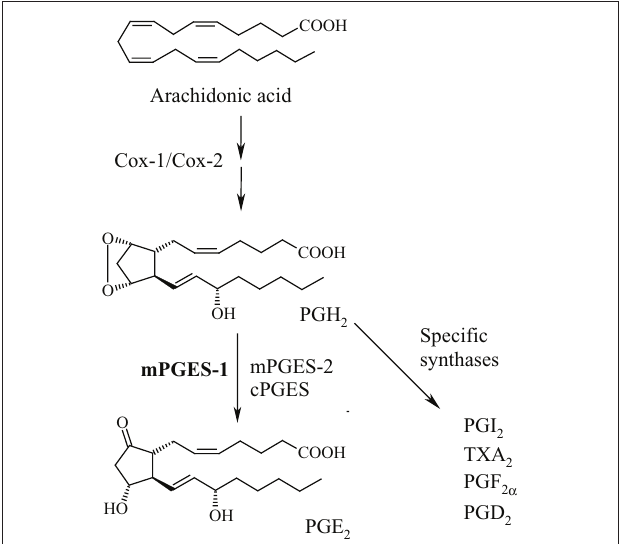
FigurE 1 | Biosynthesis of prostaglandin E produce PGH that can be converted into PGE 2 mPGES-2 or cytosolic PGES catalyze the same reaction and likely such PGE is more involved in physiological reactions. Different cells produce distinct prostaglandin profiles which reflect their expression profiles of specific prostaglandin synthases. For instance, endothelial cells produce both PGE and PGI whereas platelets predominantly produce TXA 2